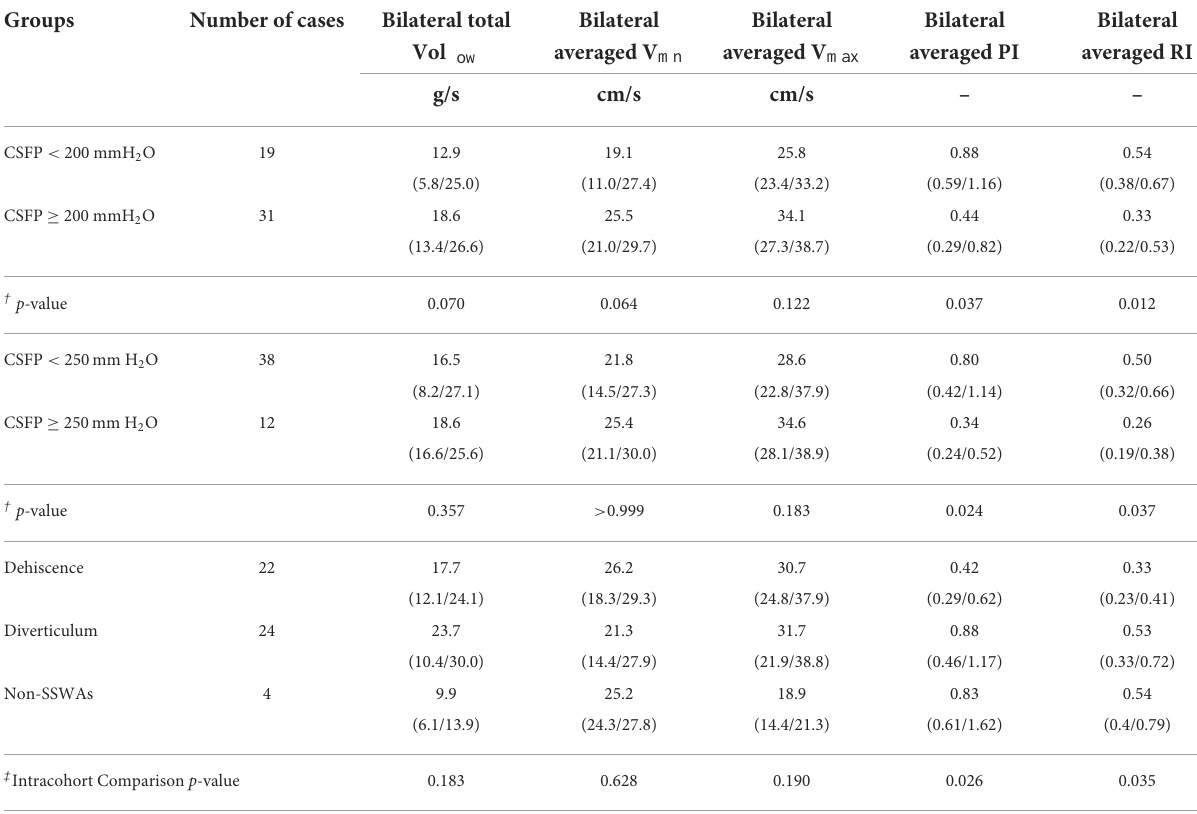
TABLE 4 Jugular hemodynamics of 50 study subjects are characterized by 200-and 250-mmH 2 O cerebrospinal fluid pressure (CSFP) thresholds and diverticulum, dehiscence, and non-SSWAs groups. Groups